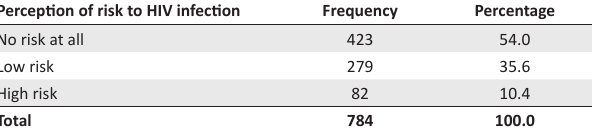
TABLE 5: Perception of risk of HIV infection. Perception of risk to HIV